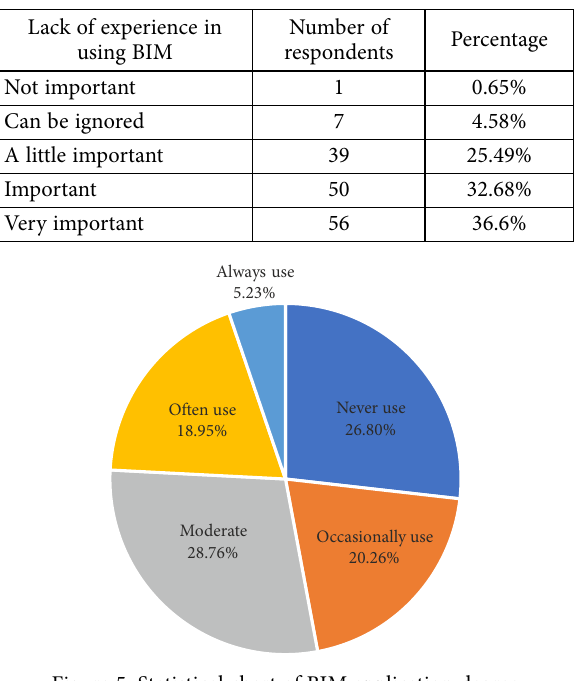
Figure 4. statistical chart of implementation degree of BIM in respondents’ companies